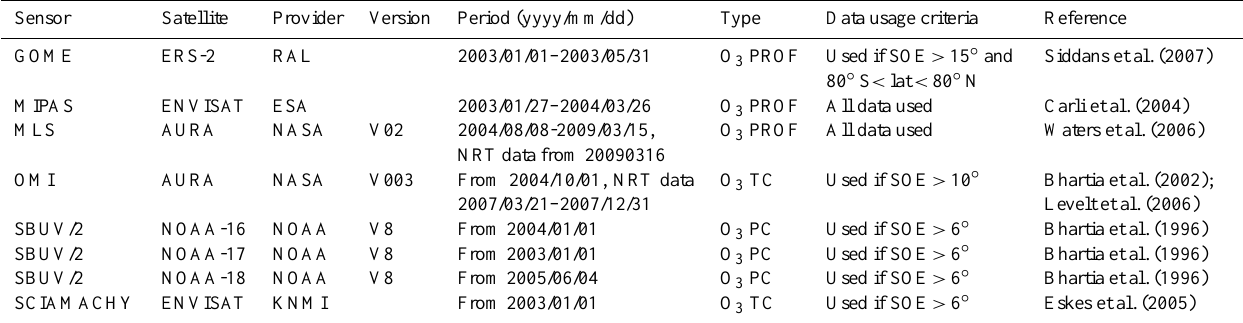
Table 1. Ozone satellite retrievals that were assimilated in the MACC reanalysis. PROF denotes profile data, TC total columns, PC partial columns, and SOE solar elevation. PC SBUV/2 data consist of six layers between the surface and 0.1hPa. NRT (near-real time) data are available within a few hours after the observation is made, and are being used in operational forecast systems. For periods towards the end of the MACC reanalysis period, NRT data were used for some of the species when no offline products were